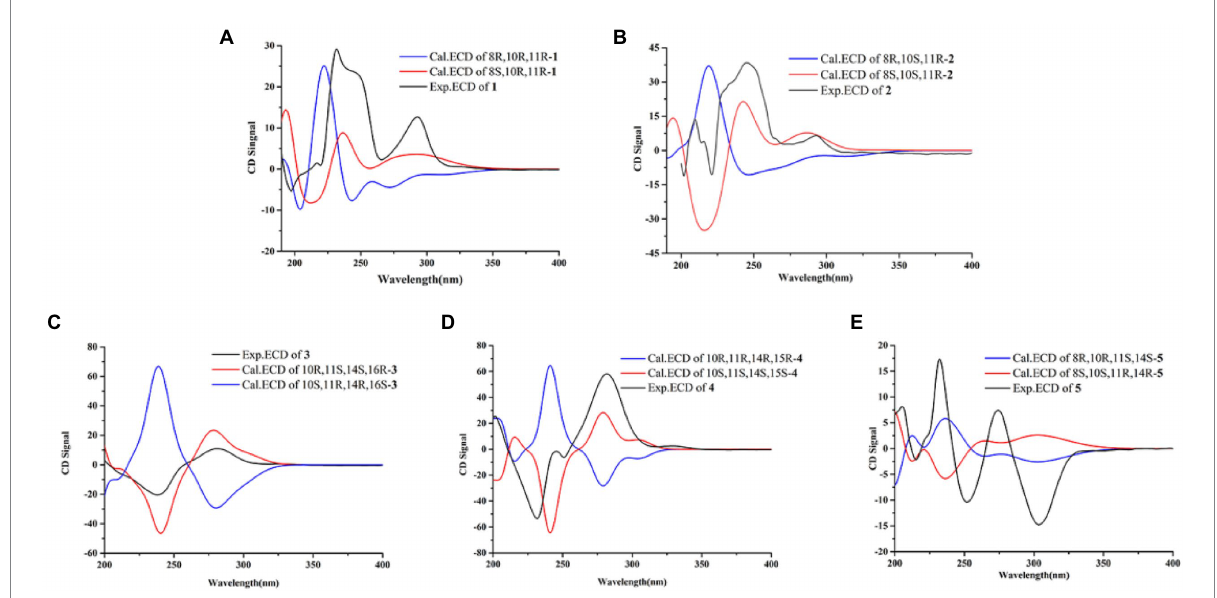
FIGURE 3 Experimental and calculated ECD curves for compound 1 (A) , compound 2 (B) , compound 3 (C) , compound 4 (D) , compound 5 (E) .